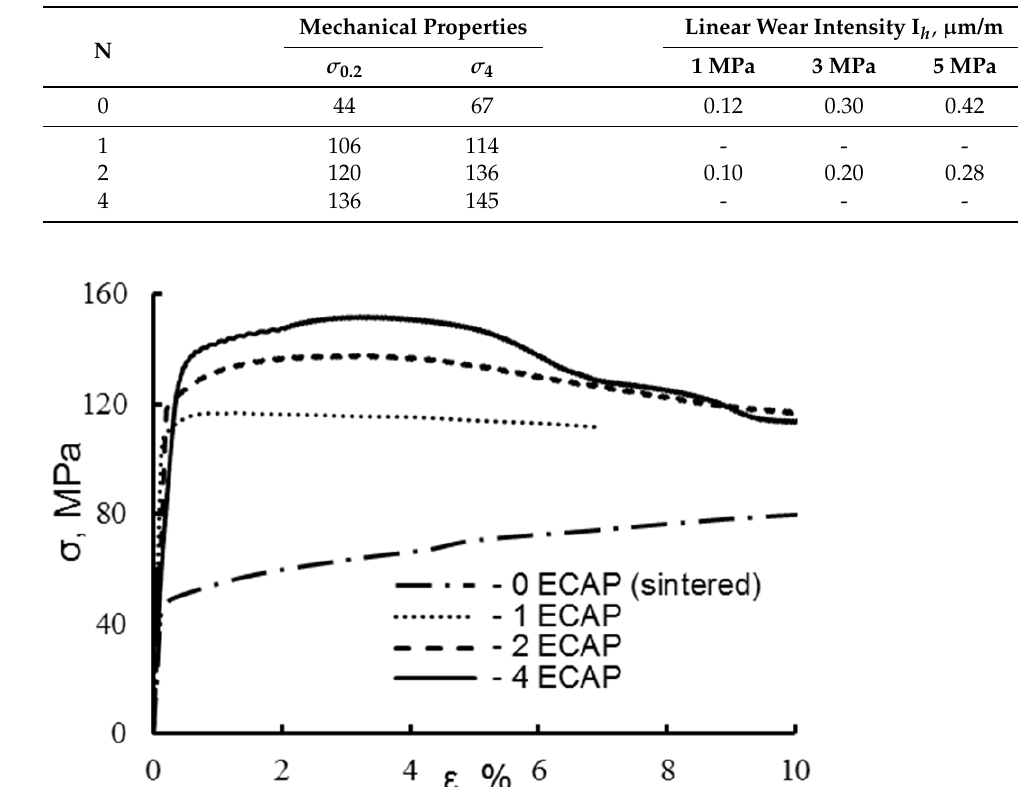
Table 1. Effect of the number of ECAP passes (N) on the mechanical properties and linear wear intensity I h at different pressures (P) under dry friction against steel of an Al-30Sn composite; V sl = 0.07 m/s; L = 500 m.